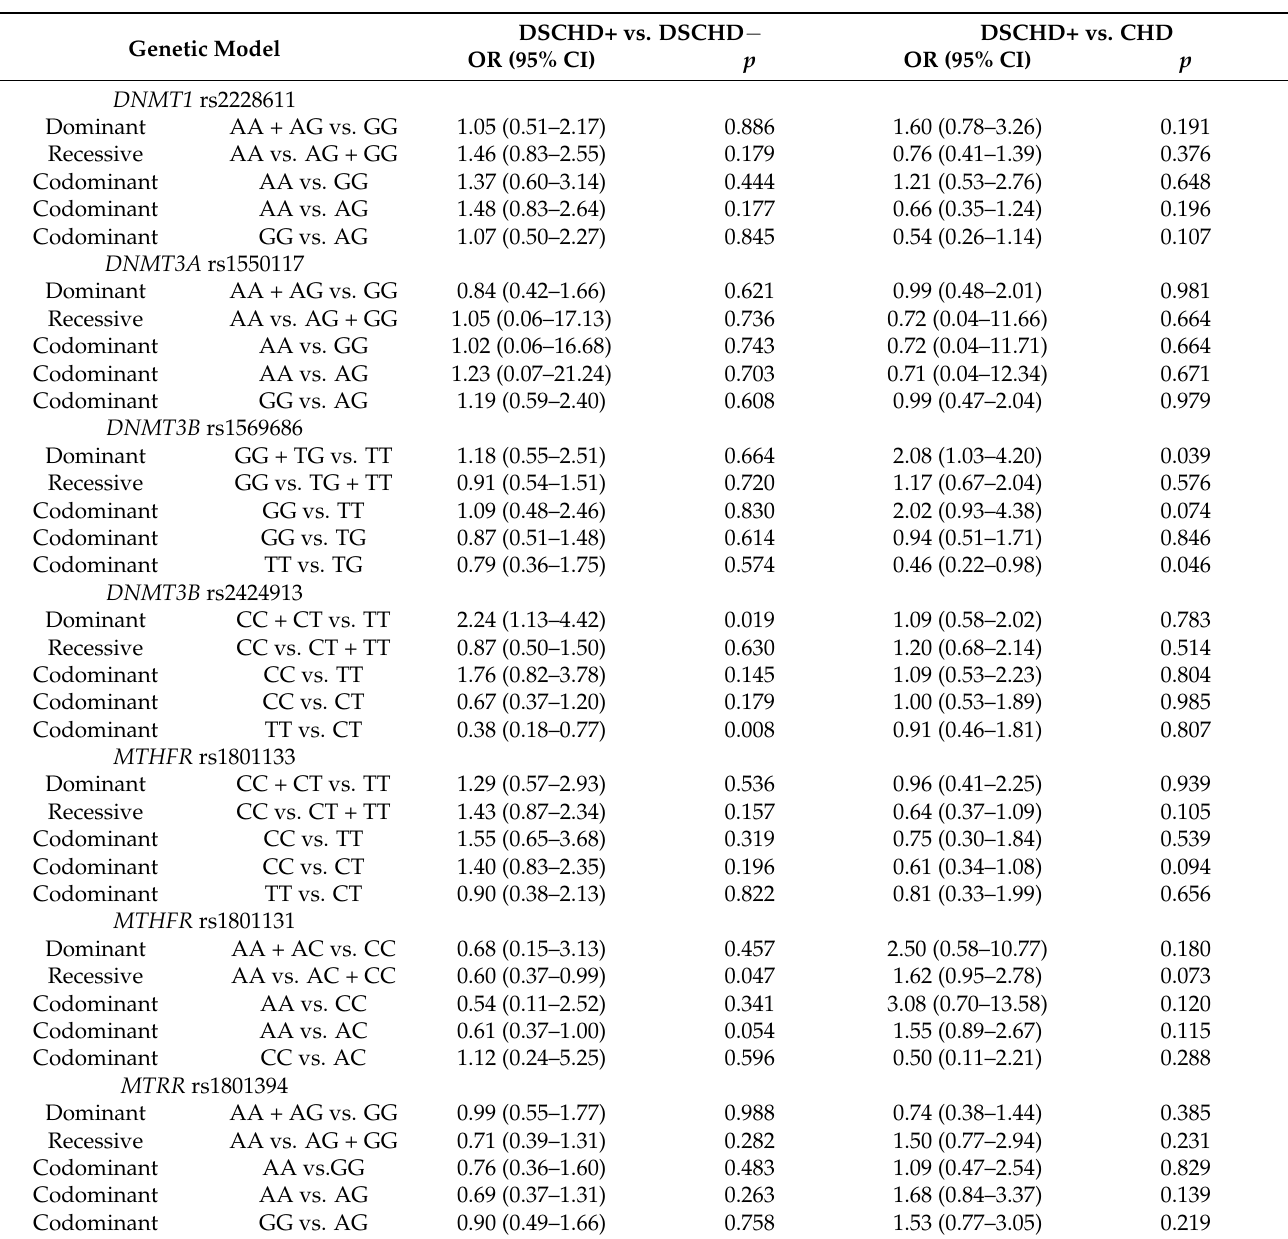
Table 3. Risk for congenital heart defects according to different genetic models in study